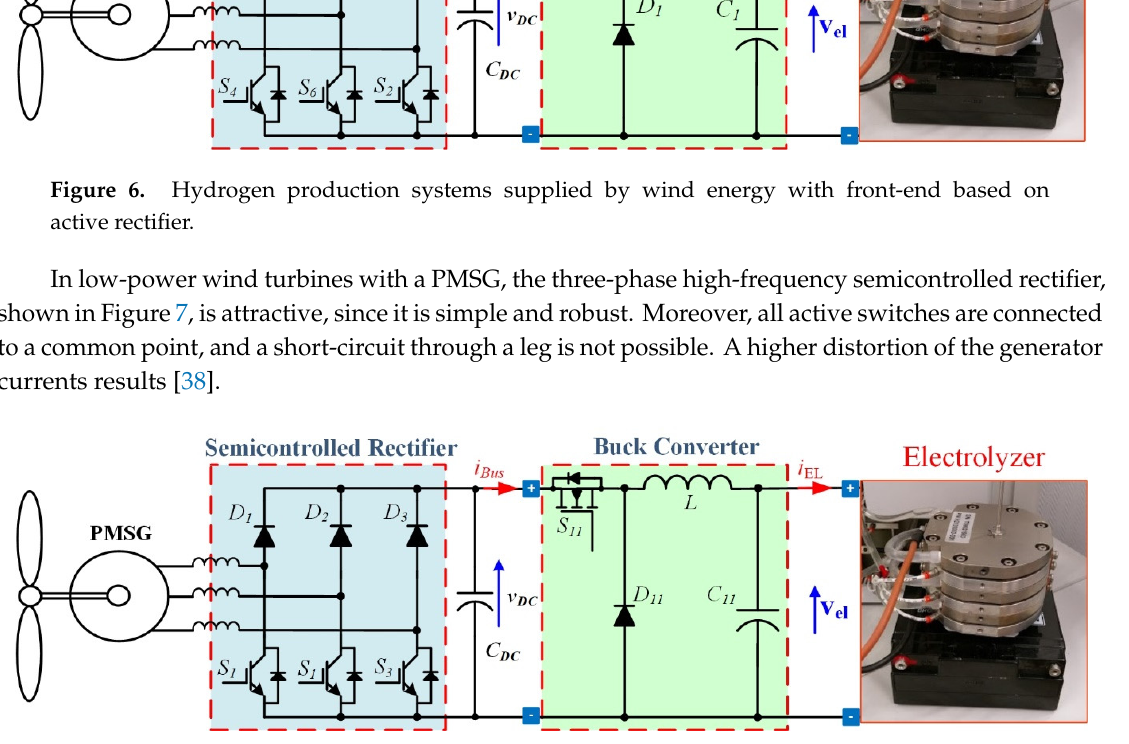
Figure 7. Hydrogen production systems supplied by wind energy with front-end based on semicontrolled rectifier.